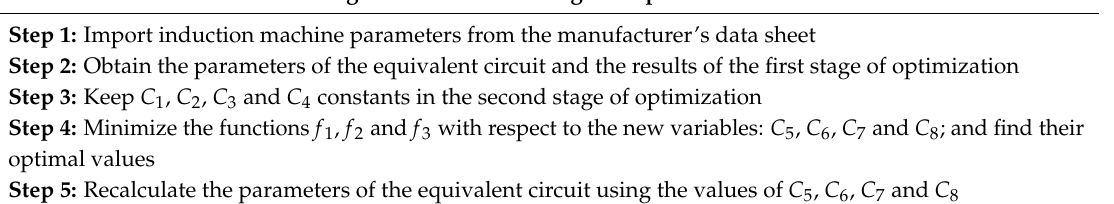
Algorithm 2: Second Stage of Optimization.